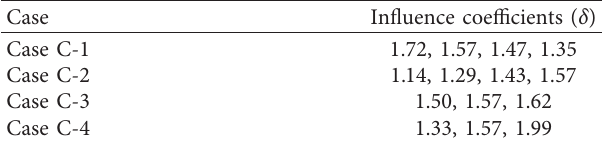
Table 12: Influence coefficients of cruciform connection in dif- ferent